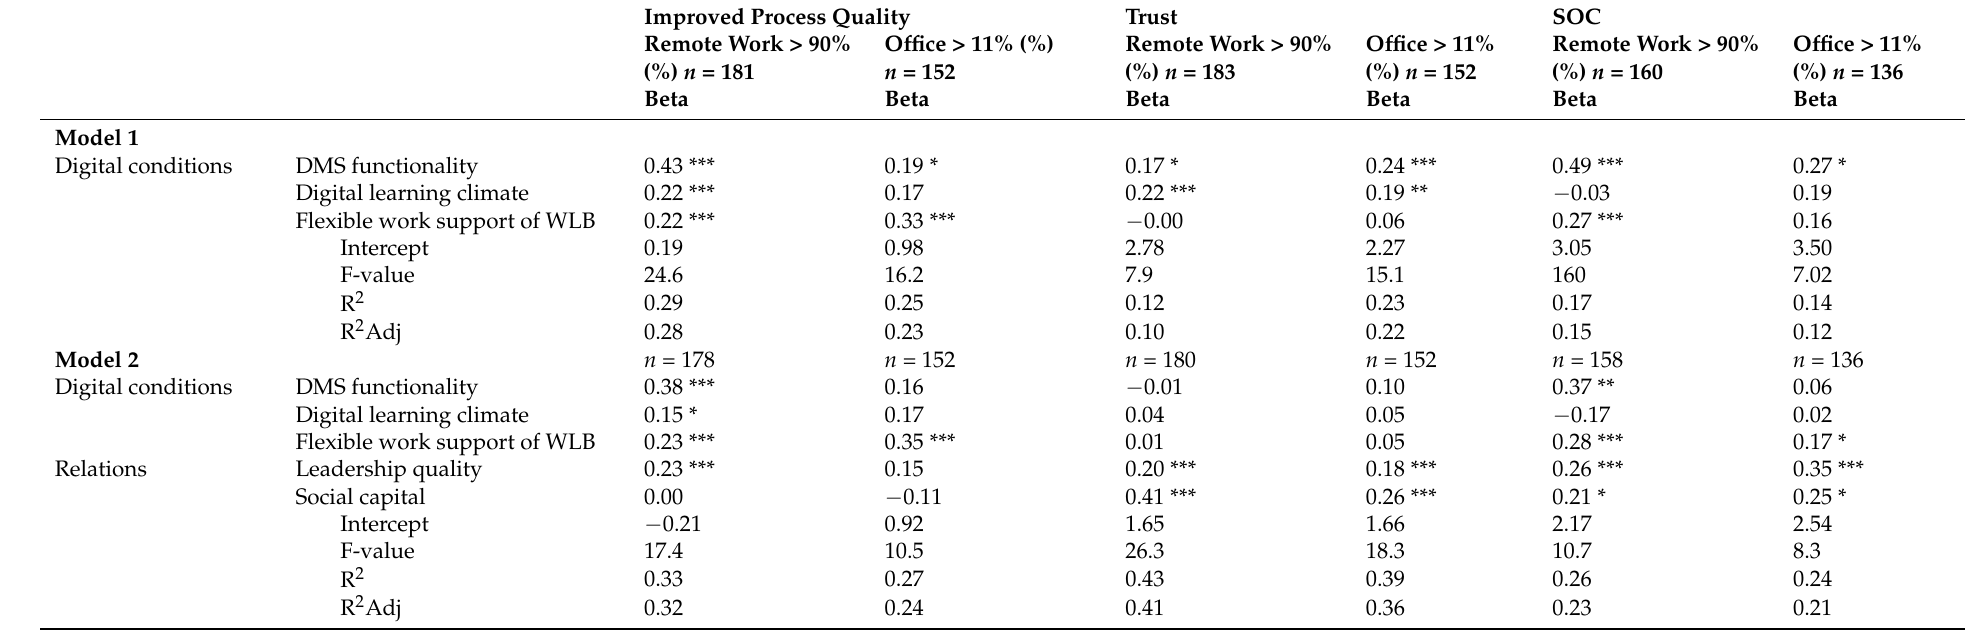
Table 3. Linear models of the importance of digital tools and relational aspects for performance, trust, and